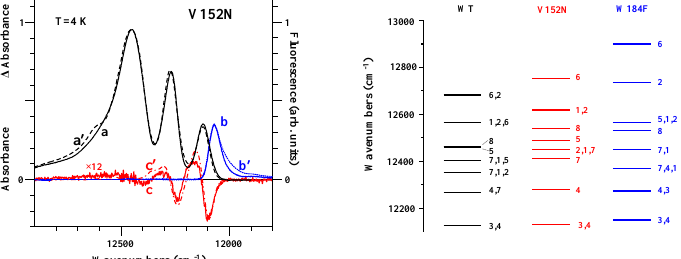
Fig. 2. Left frame: Black spectra are the experimental/simulated (solid/dashed curves a/a ʹ ). Blue curves show the experimental/simulated (solid/dashed curve b /b ʹ ). Red curves c and cʹ correspond to the experimental (solid) and calculated (dashed-dotted) nonresonant HB spectra; ν ex = 20,490 cm -1 for V152N FMO mutant at T = 4 K. Right frame: exciton energy level scheme for monomers of WT and three mutants based on our calculations. Dominant pigment contributions (>15%) for each exciton are indicated by corresponding BChl